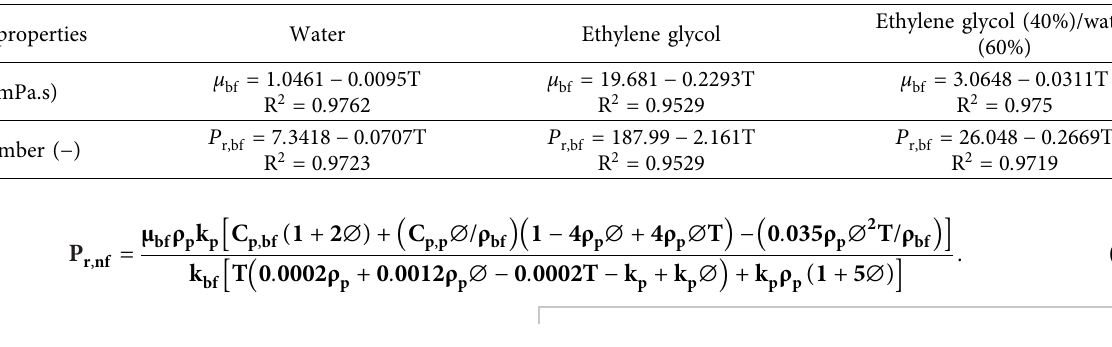
Table 2: Viscosity and Prandtl number base fuid